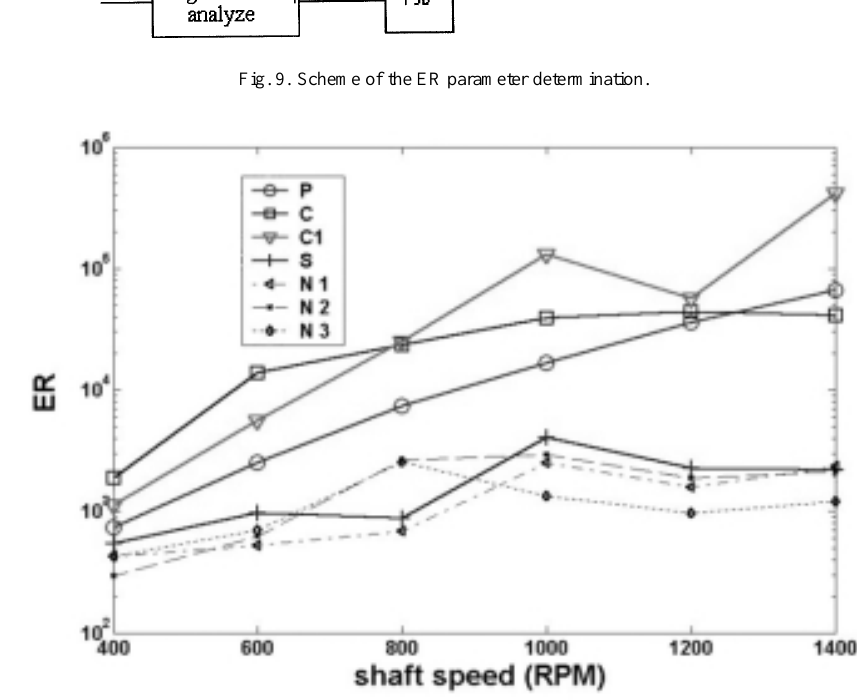
Fig. 10. ER of the acceleration signal as a function of the rotating shaft speed, load